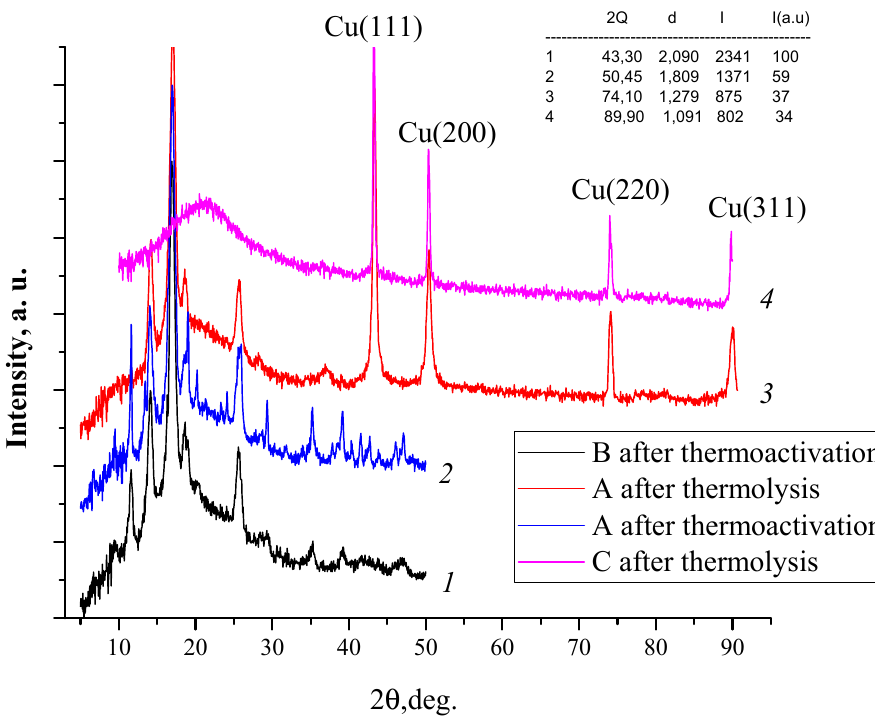
Figure 10. XRD patterns of copper trimesinates B ( 1 ), A ( 2 ) and the Cu@C ( 3, 4 ) samples obtained by